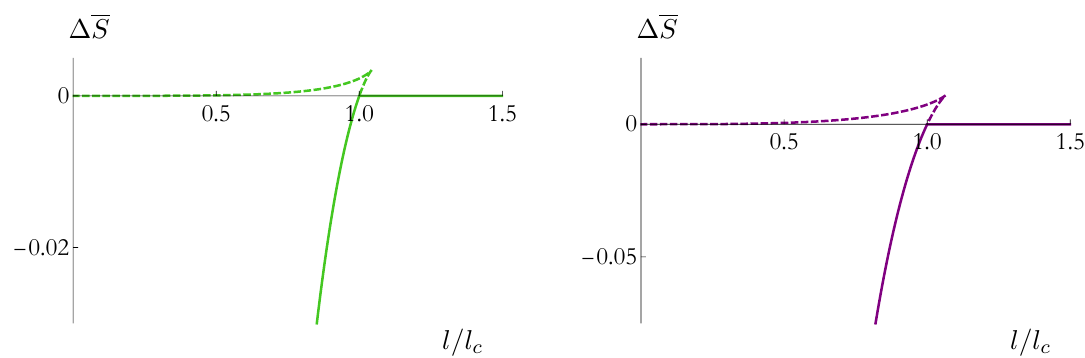
Figure 4. Entanglement entropy of a single strip as a function of the width of the strip in the gapped non-confining theory B 0 (Left) and in the confining one B conf (Right). We plot the rescaled 8 8 quantity (B.6) defined in appendix B as a function of the strip width normalized to the value above which the “disconnected” configuration t becomes the dominant